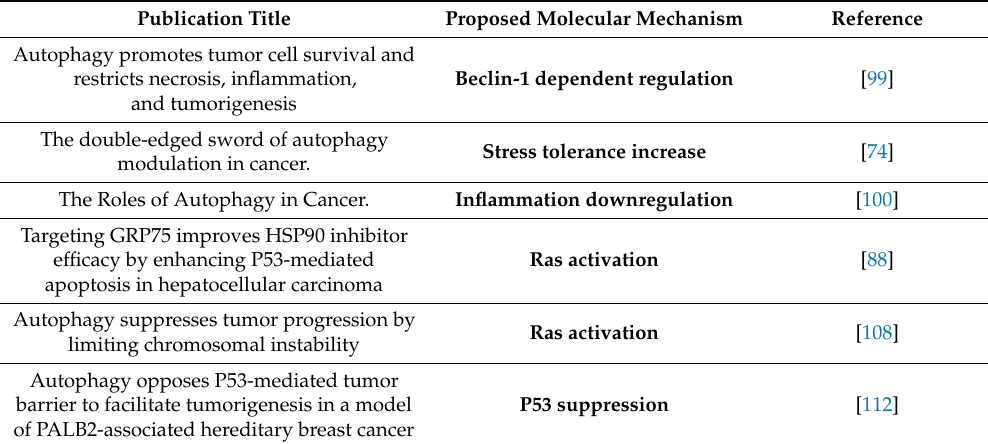
Table 3. Summary of analyzed publications highlighting the tumor growth promoter role of